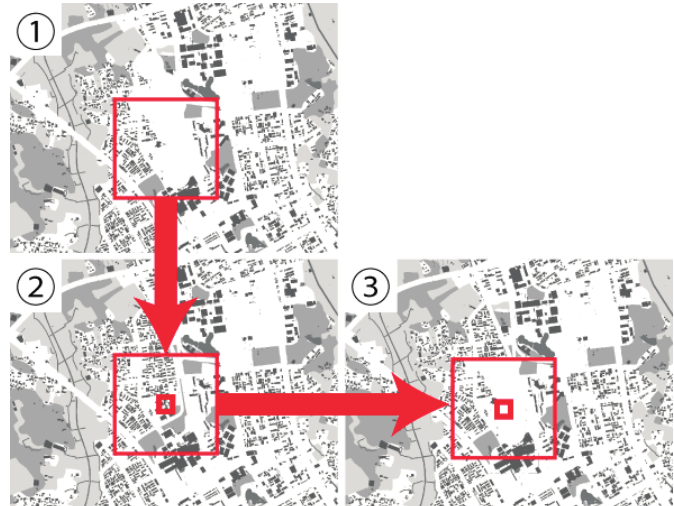
Figure 6. Map data update method.